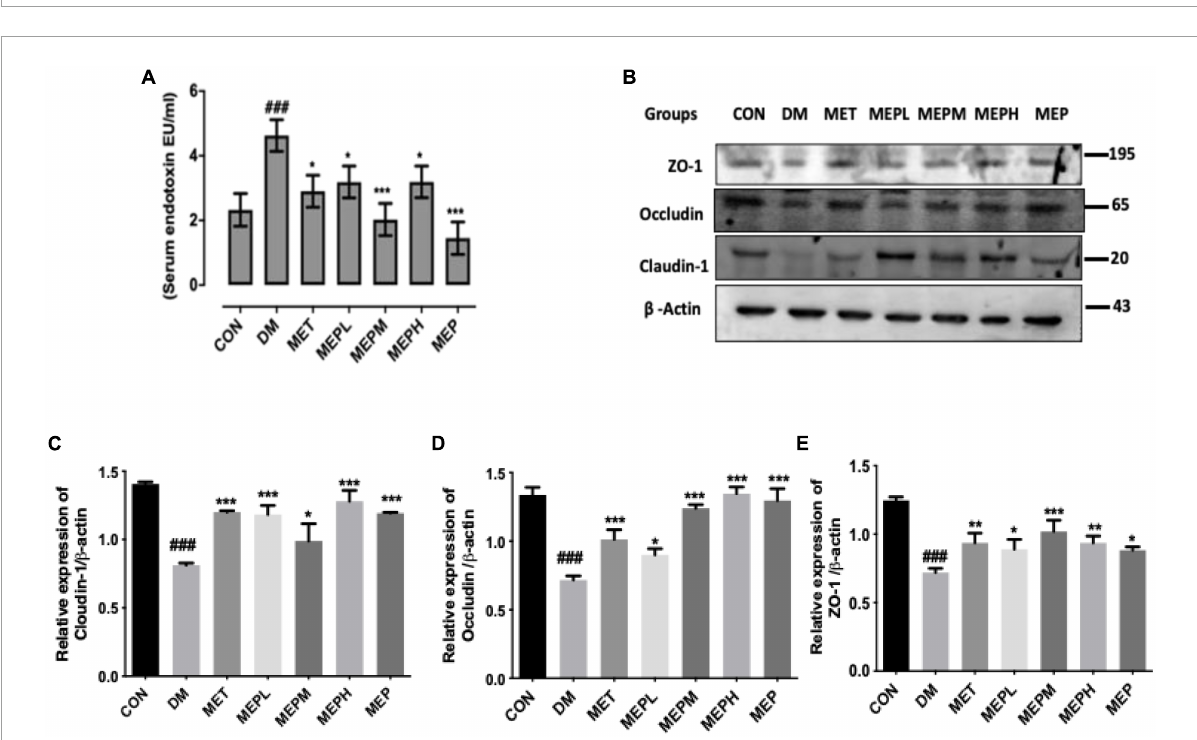
FIGURE8 Effect of MEP treatment on serum endotoxin LPS (lipopolysaccharide) levels and colon tight junction proteins in T2DM mice. (A) Effect of MEP on T2DM induced endotoxemia. Serum LPS Level was measured by serum endotoxin (EU mL) Limulus amoebocyte lysate assay. (B) Effect of MEP on colon tight junction proteins (ZO-1, occludin, and slaudin-1) in T2DM mice. (C–E) Bar graph showing quantification of the western blot of the respective protein against β -actin as an internal control by Image J software. The data was obtained by three independent experiments and is expressed as mean SEM ( n = 3). # indicates a significant difference compared with control (CON) group. ### p < 0.001 vs. control. * indicates a significant difference compared with the DM group. * p < 0.05, ** p < 0.01 and *** p < 0.001 vs. DM. Data were presented as mean ±